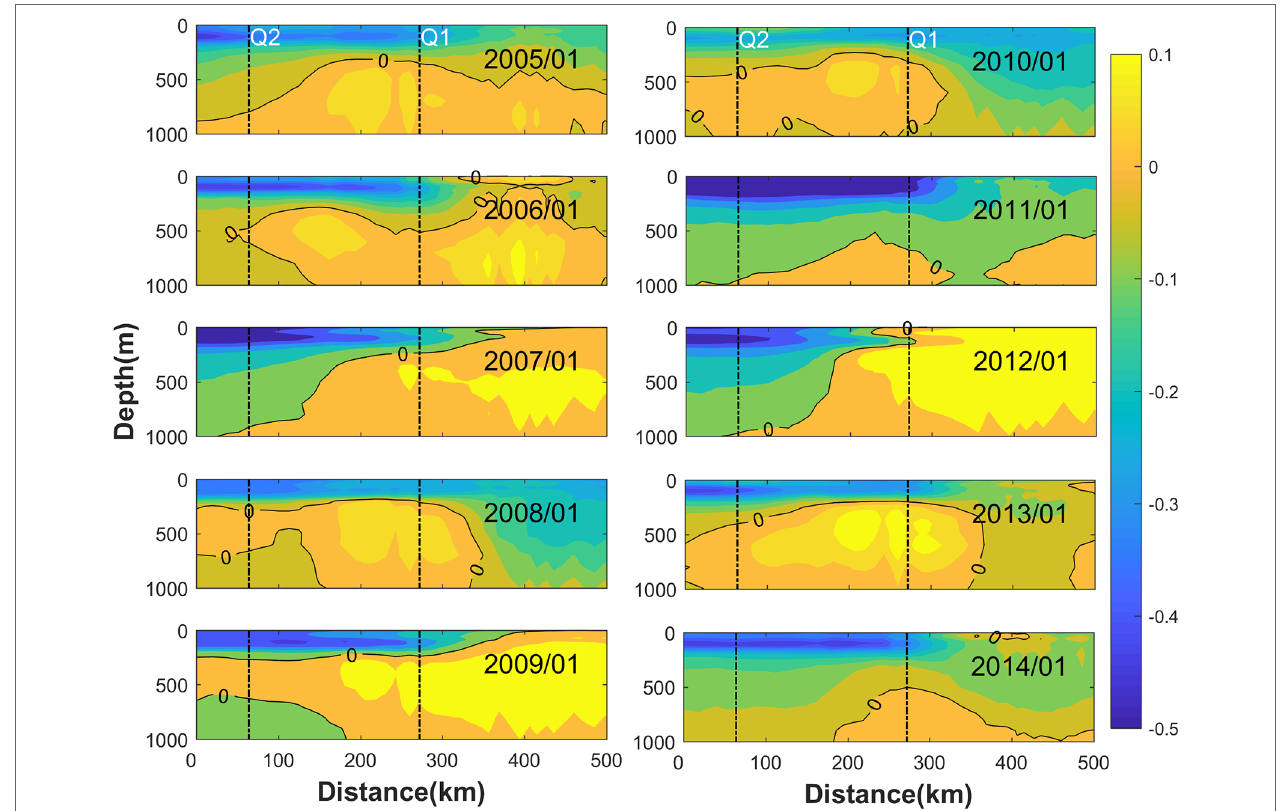
FIGURE 9 | Mean along-slope current (m/s) from HYCOM output along the 1000-m isobath in January for the years from 2005 to 2014. The black contours indicate zero flow speed. The along-isobath distances of mooring stations Q1 and Q2 are indicated with black dotted